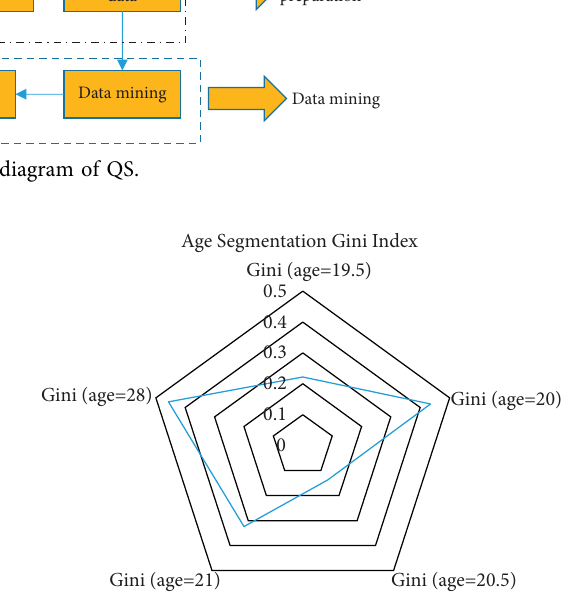
Figure 7: Gini segmentation index of age